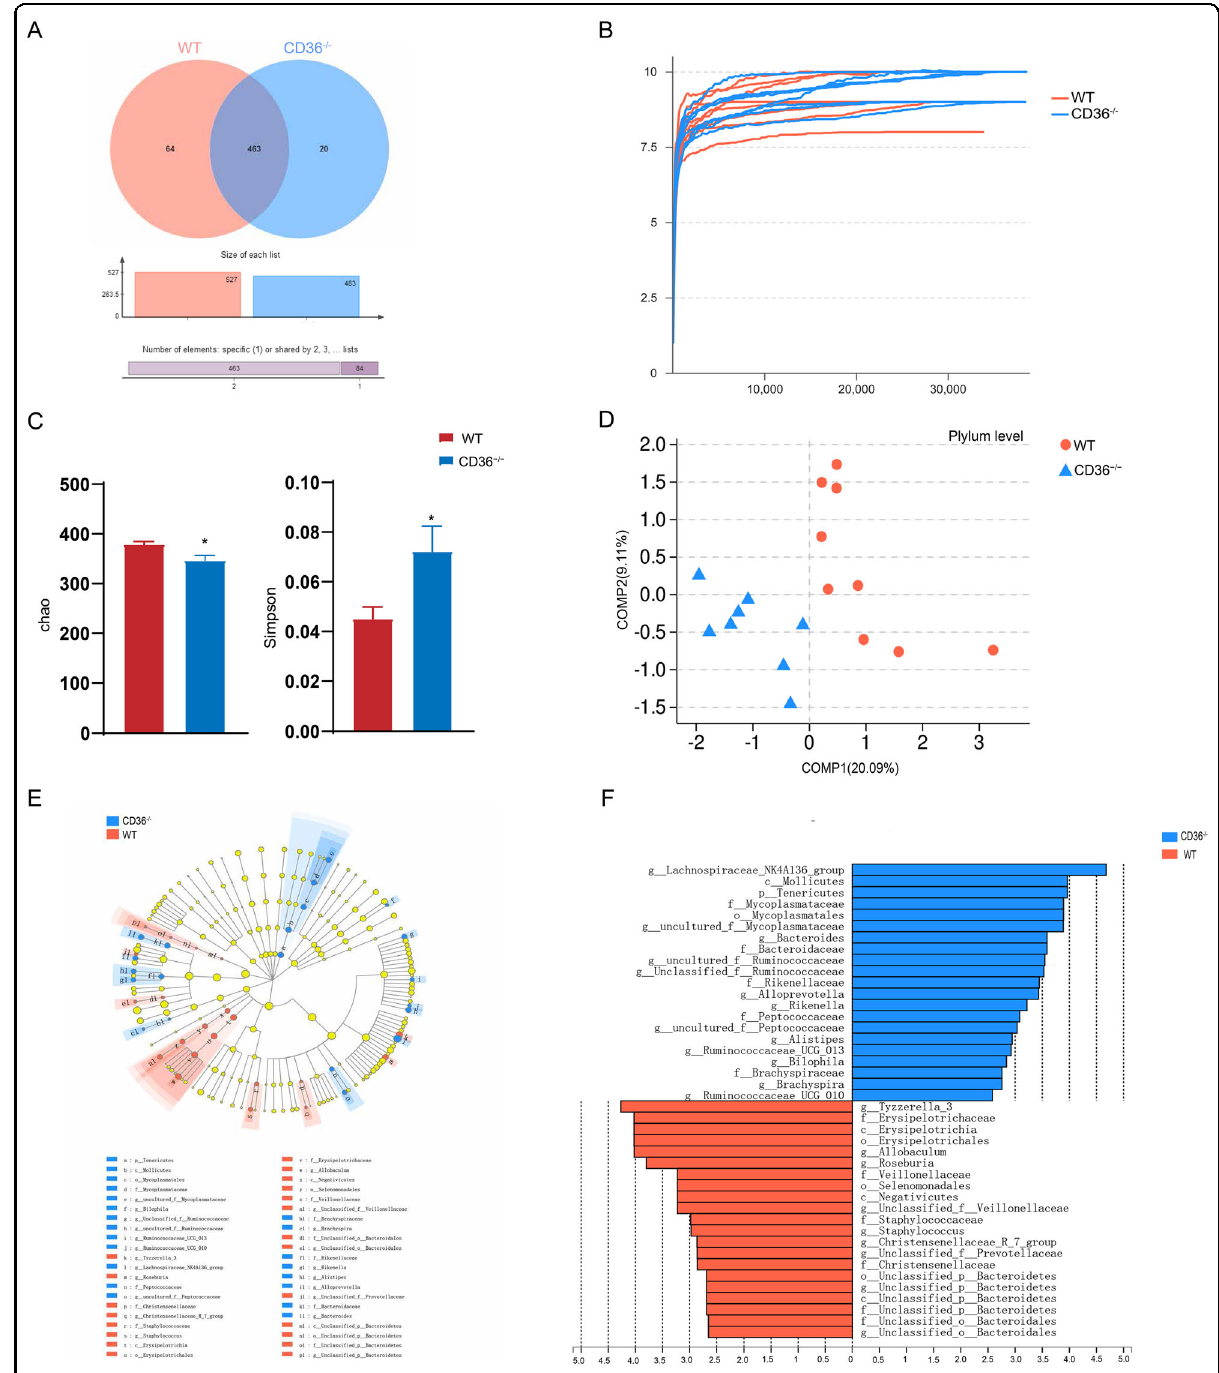
Fig. 2 CD36 knockout affects the gut microbiome compared with WT mice. a A Venn diagram of OTUs detected in WT and CD36 − / − mice. b The majority of rarefaction curves tended to approach the saturation plateau. c Alpha-diversity analysis showed that CD36 − / − mice were characterized by lower microbial richness (Chao, n = 8 – 9 mice/group, * P < 0.05) and higher microbial diversity (Simpson, n = 8 – 9 mice/group, * P < 0.05) relative to WT mice. d At the phylum level, partial least-squares discriminant analysis (PLS-DA) showed that gut microbiota composition in CD36 − / − mice was greatly different from that in WT animals. e LEfSe identi fi ed the most differentially abundant taxons between WT and CD36 − / − mice — (red) WT taxa; (blue) taxa enriched in CD36 − / − mice. The brightness of each dot is proportional to its effect size. f Taxa enriched in CD36 − / − mice are indicated with a positive LDA score (green), and taxa enriched in WT mice have a negative score (red). Only taxa meeting an LDA signi fi cance threshold >2 are